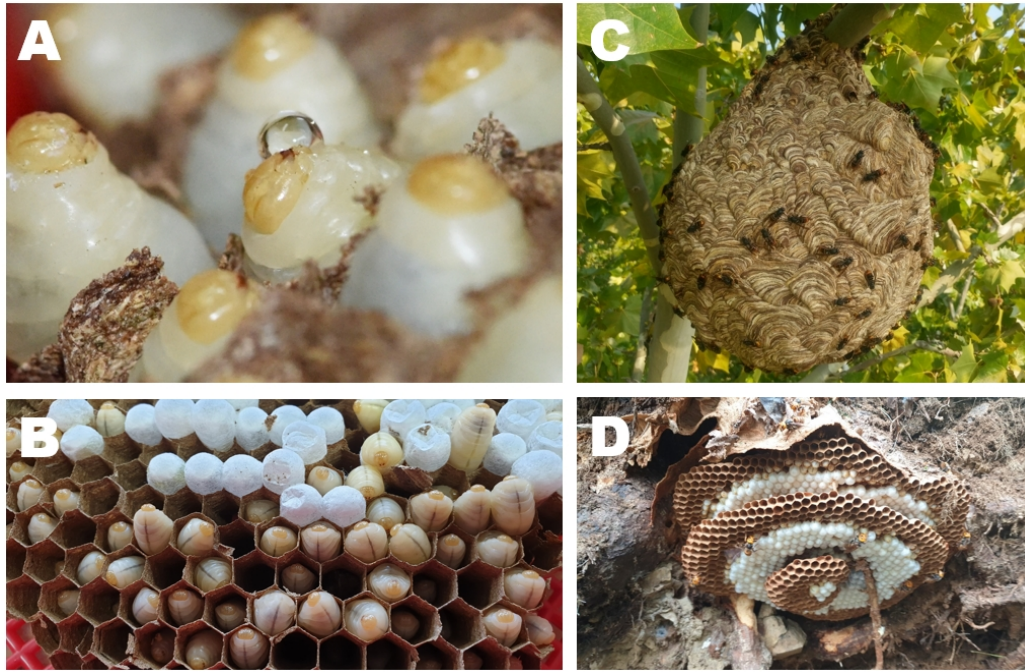
Figure 1. The nest of V. v. nigrithorax that hovers larvae. ( A ) Larvae of V. v. nigrithorax secreting saliva; ( B ) larvae of V. v. nigrithorax in cells; ( C ) the nest of V. v. nigrithorax hung on a tree; ( D ) the nest of V. mandarinia.